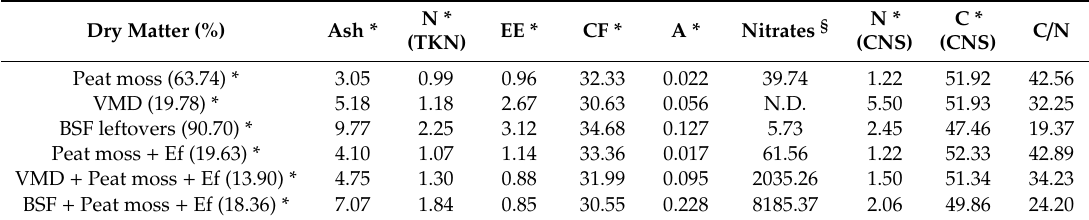
Table 9. Chemical analyses of the three growing substrates and of resulting organic soil